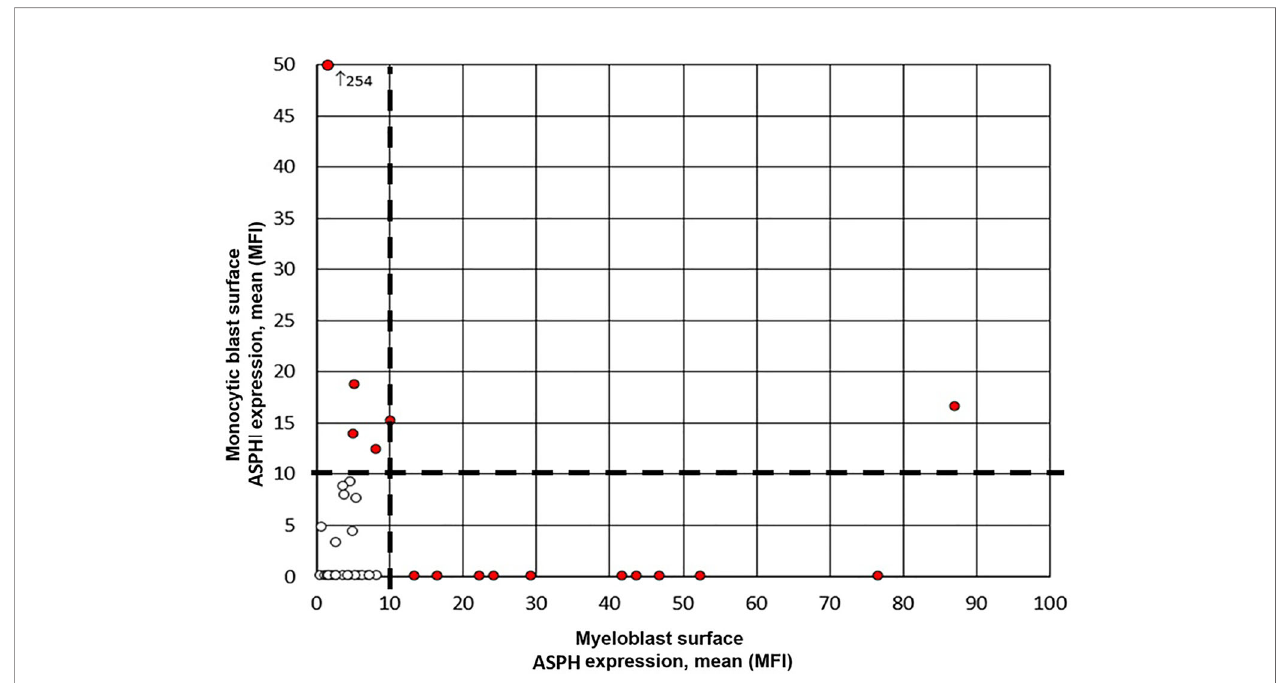
FIGURE 1 | ASPH surface expression on myeloblasts and monoblasts. Expression data for the whole patient population showed a ‘ mixed population ’ , i.e. a clustering of patients with low or zero expression mixed with patients with stronger expression, which was used to identify a robust cut-point of 10 MFI (black dashed line) separating high (i.e., positive, red circles) from low (i.e., negative, white circles) mean ASPH expression on myeloblast (x-axis) or monoblast (y-axis)